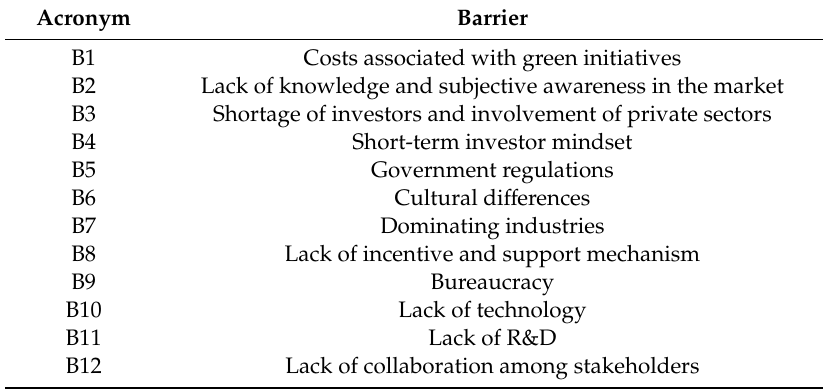
Table 1. Barriers to green entrepreneurship (GE).